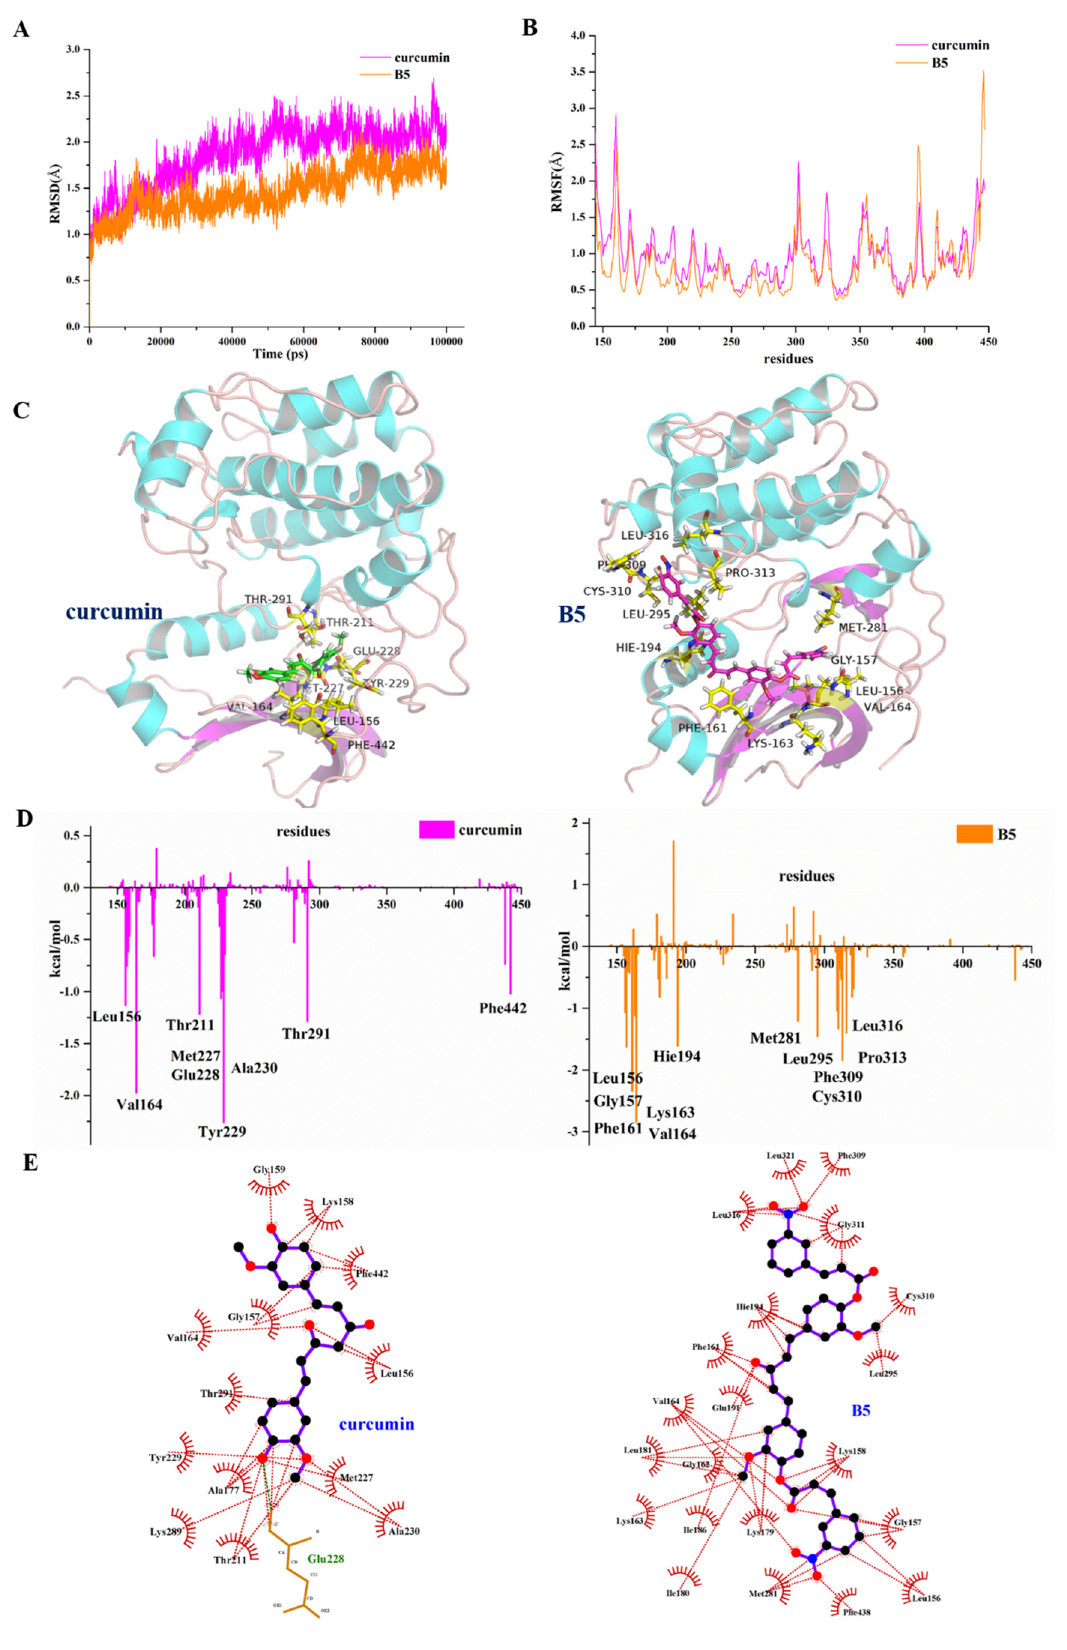
Figure 7. Predicted binding mechanism of AKT in complex curcumin or B5 after 100 ns MD simula- tions. ( A ) RMSD changes. ( B ) RMSF changes. ( C ) The conformations and specific binding modes. ( D ) Decomposition free energy calculated by MM-GBSA. ( E ) hydrophobic